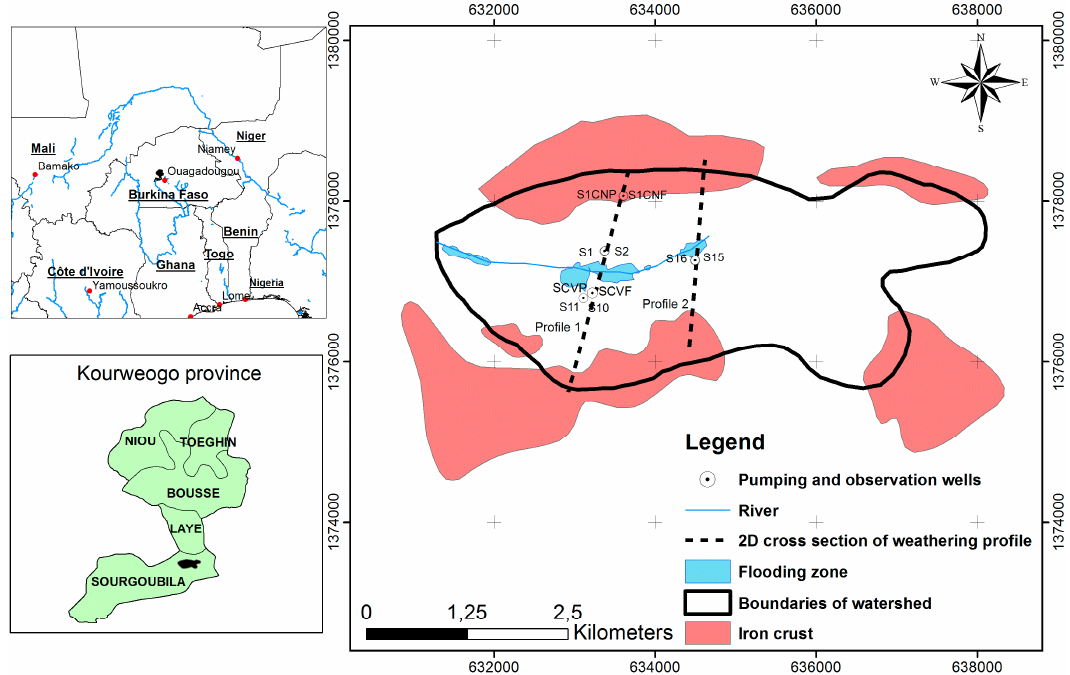
Figure 1. Location of the Sanon experimental site showing boreholes used for well test, profile sections within the catchment.